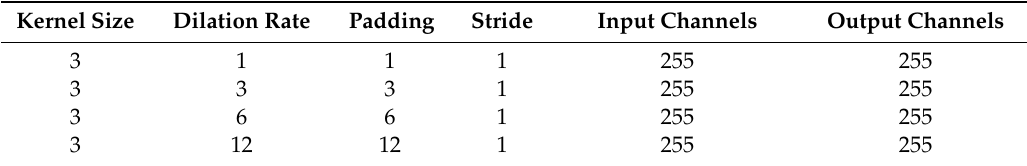
Table 2. Parameter settings in the dilated convolution